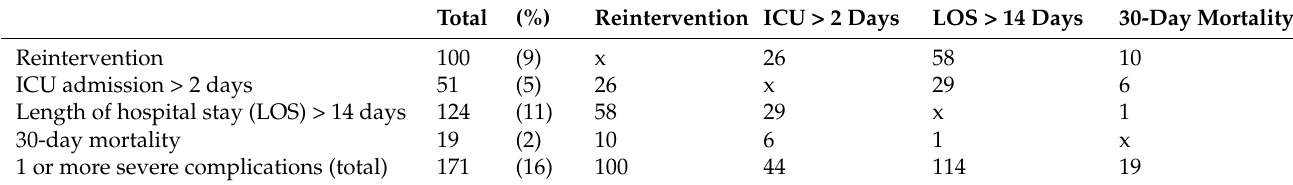
Table A1. Specification of One or More Severe Complications.